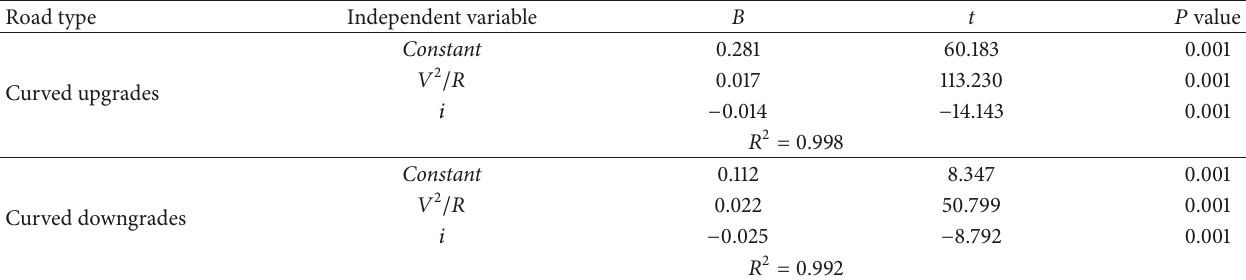
Table 9: Results of statistical analysis for LTR cornering on upgrades and